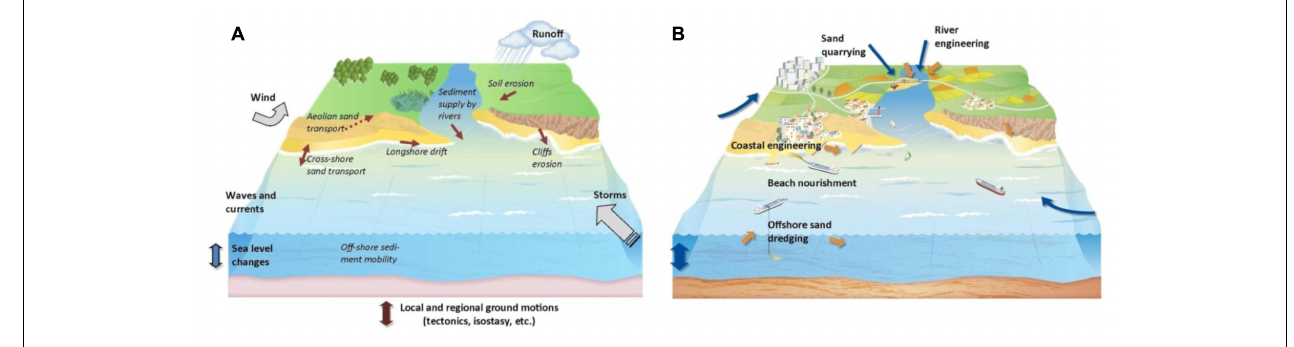
FIGURE 1 | Natural (A) and anthropogenic (B) processes affecting shoreline changes (source: Cazenave and Le Cozannet,